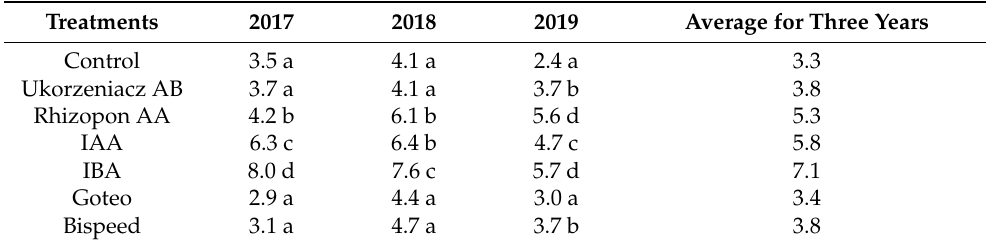
Table 4. Fresh mass (g) of softwood cuttings of GiSelA 5 rootstock depending on the tested treatments in the years